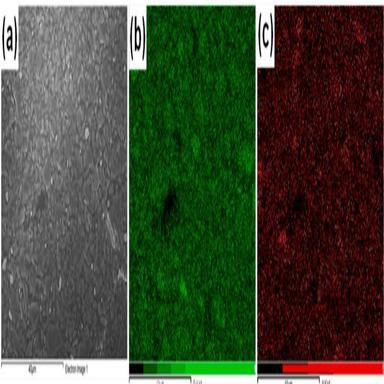
EDS mapping of the PVA/Gr-11 wt% NQNs nanocomposite. (a) SEM image of the nanocomposite where the mapping was applied. (b) EDS mapping of Si, and (c) EDS mapping of Al.